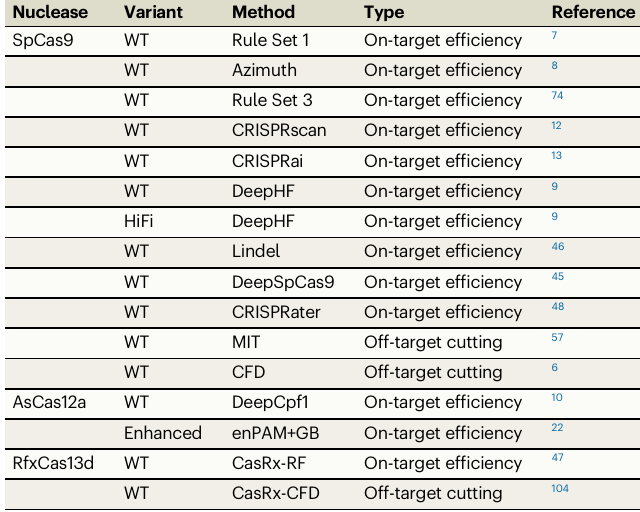
Table 3 | On-target and off-target scoring methods currently available in crisprScore